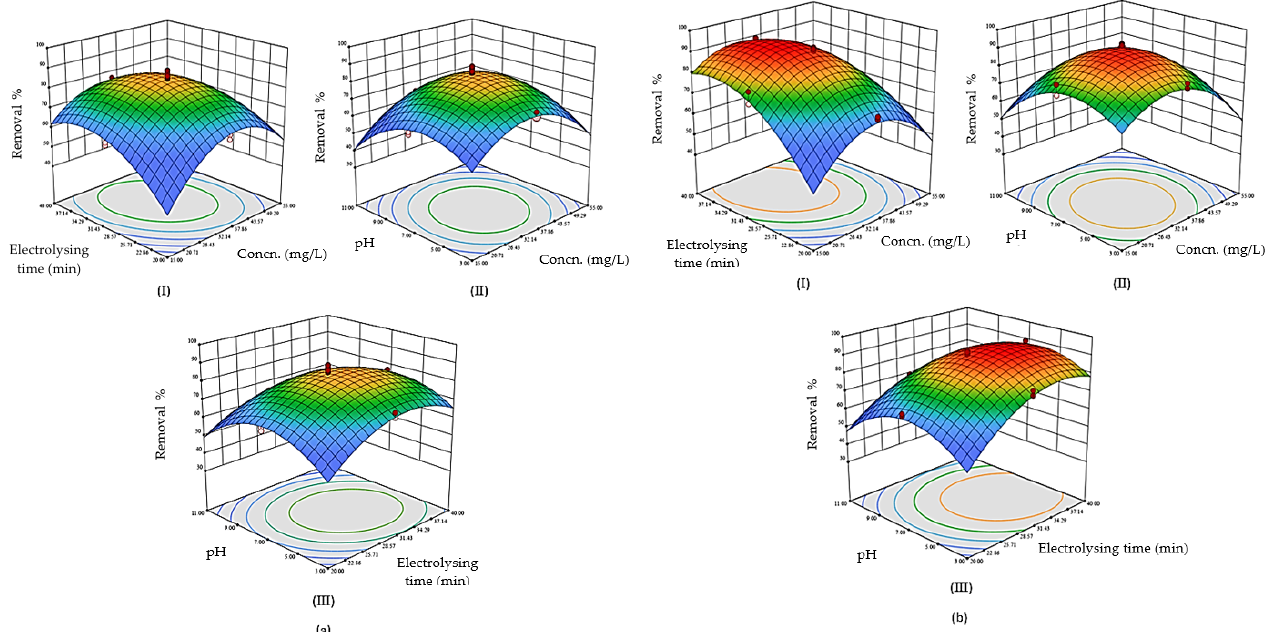
Figure 4. Response surface plot illustrating the effect of operating parameters on the CEX removal efficiency ( a ) non-insulated electrode ( b ) insulated electrode (I) initial CEX concentration and electrolysis time, (II) initial CEX concentration and initial pH, (III) initial electrolysis time and pH.